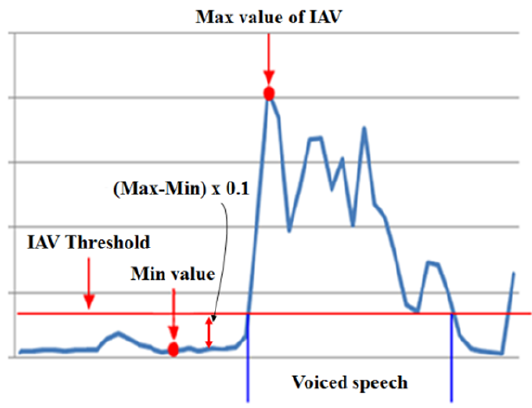
Figure 2. An example of determining threshold.